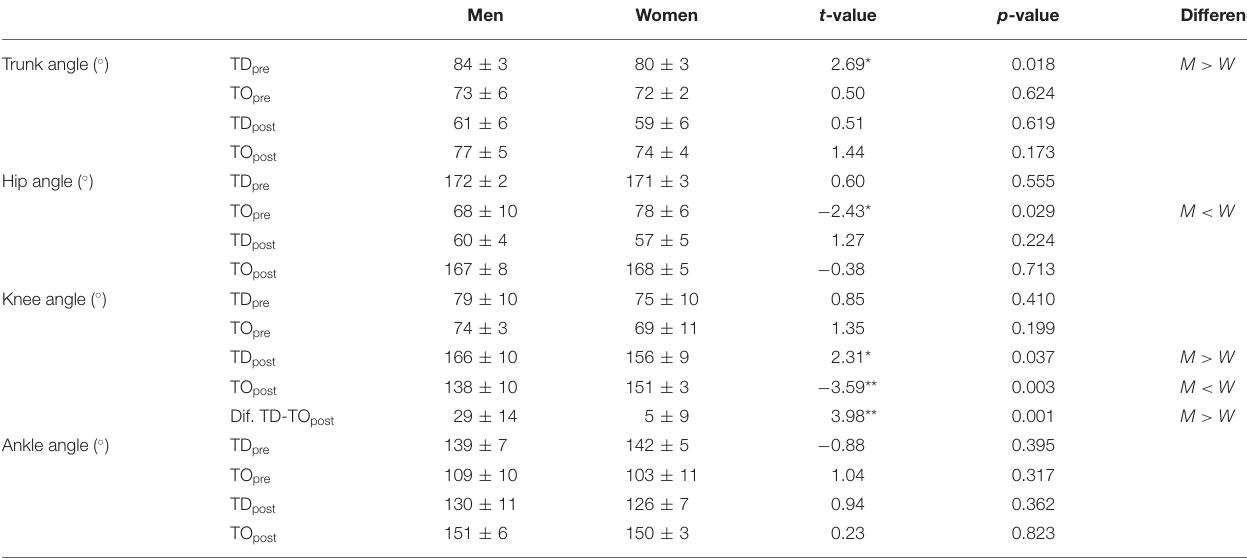
TABLE 1 | Kinematic characteristics of men and women at key events (TD pre , TO pre , TD post , TO post